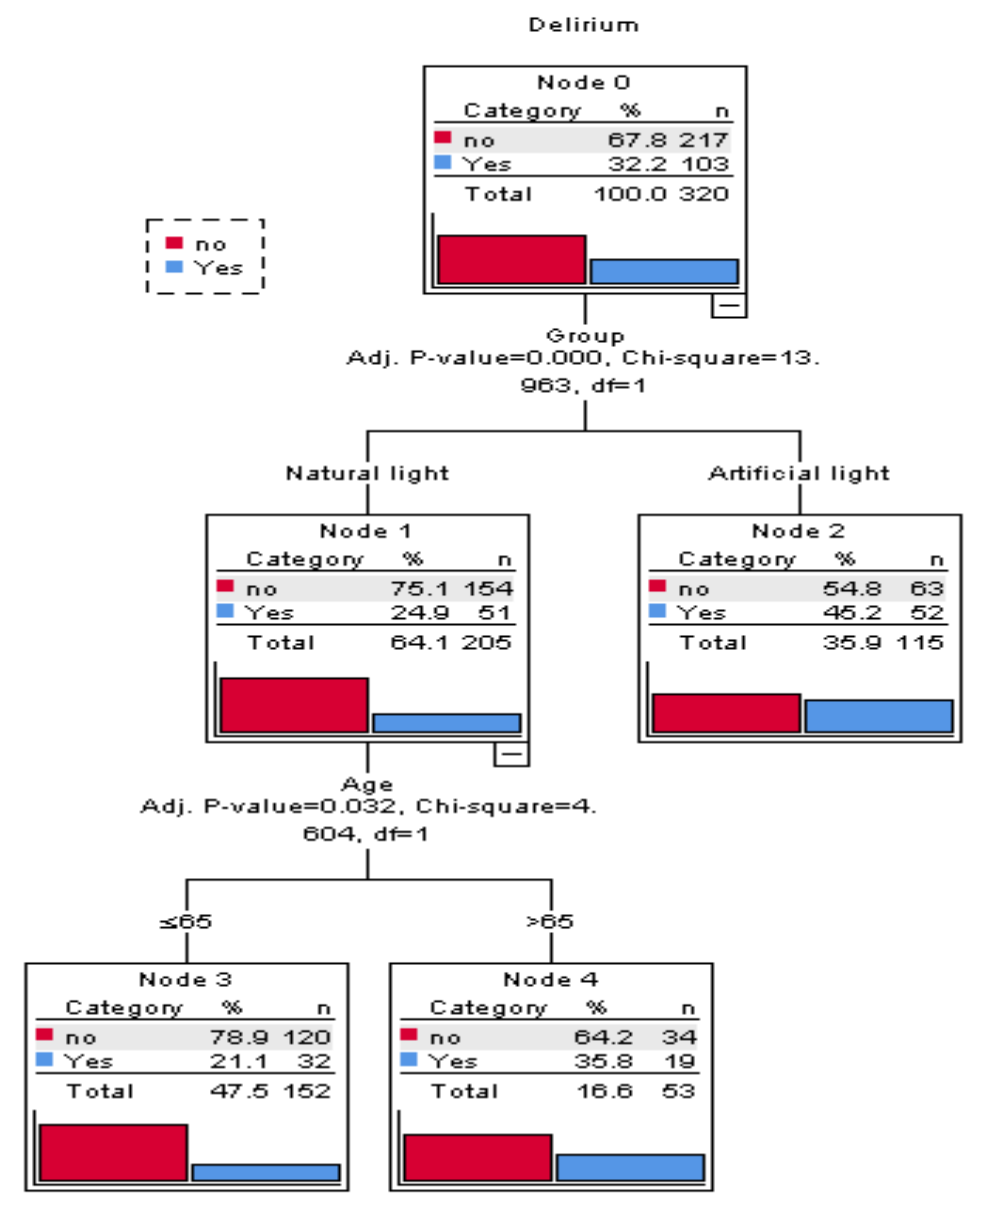
Figure 3: A CHAID decision classification tree analysis to predict delirium recurrence in patients with delirium at the admission